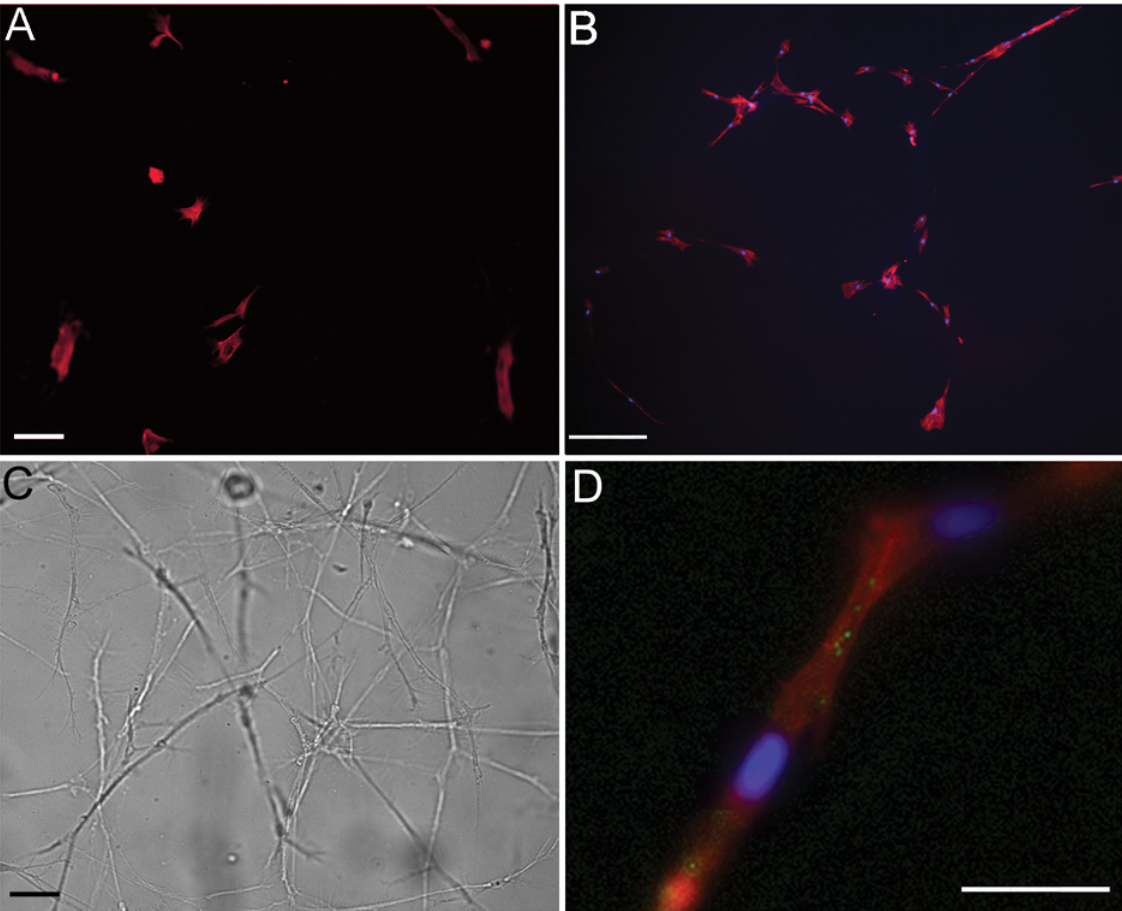
Figure 8. Fibrin gels stimulate cell patterning in 2D and 3D. Characteristic fluorescence image of F-actin structures in hMSCs cultured for 4 days on 16 kPa fibrinogen coated polyacrylamide (A) or 2 mg/ml fibrin (B). C) A bright field image of hMSCs cultured in 3D for 7 days in a 2 mg/ml gel. D) A fluorescently stained junction between two hMSCs in a 3D fibrin gel. For all images F-actin is labeled in red, the nucleus in blue and connexin 43 in green. Scale bar=100 m m for all